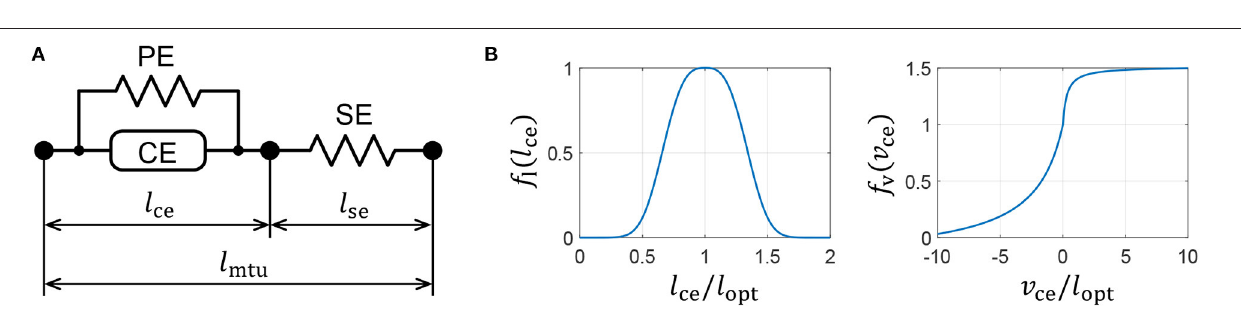
FIGURE 3 | Muscle properties reproduced on a quadruped robot. (A) Hill-type muscle model. (B) Force–length and force–velocity characteristics of the contractile element (CE).